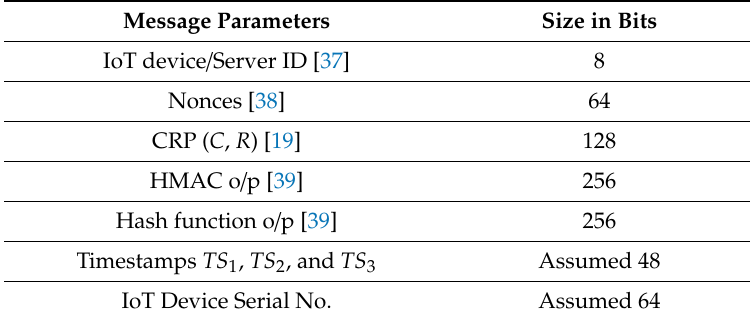
Table 5. Authentication messages’ parameter values.